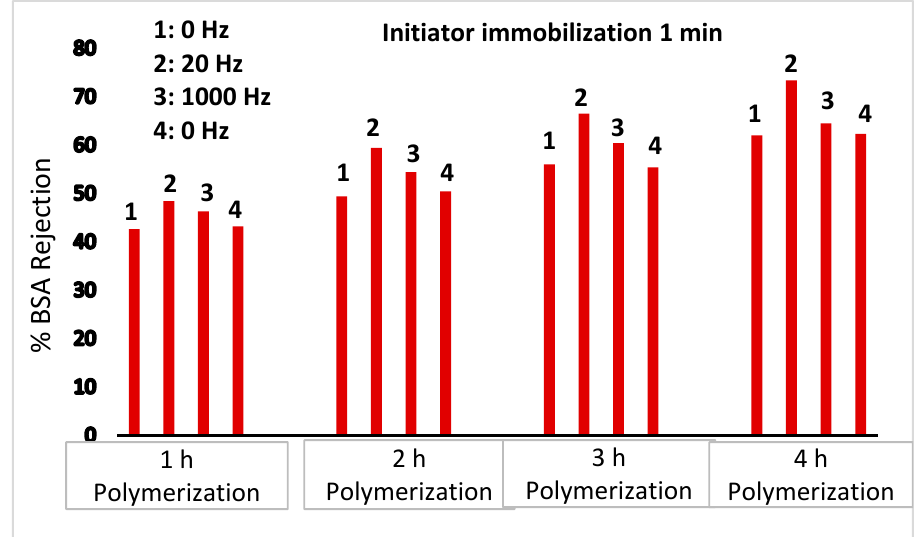
Figure 5. Variation of BSA rejection for outer membrane surface modification. Results are shown in the absence and presence of a 20 and 1000 Hz oscillating magnetic field.